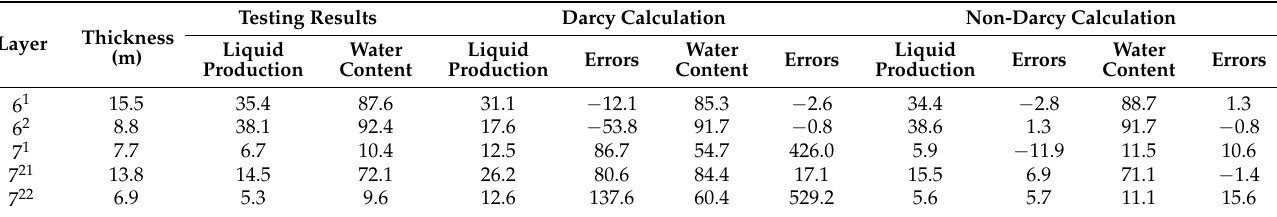
Figure 18. The well profiles of remaining oil saturation Wells Y120 and Y4-7-1. Table 4. Testing results of liquid production in in Y4-5-14 Well.